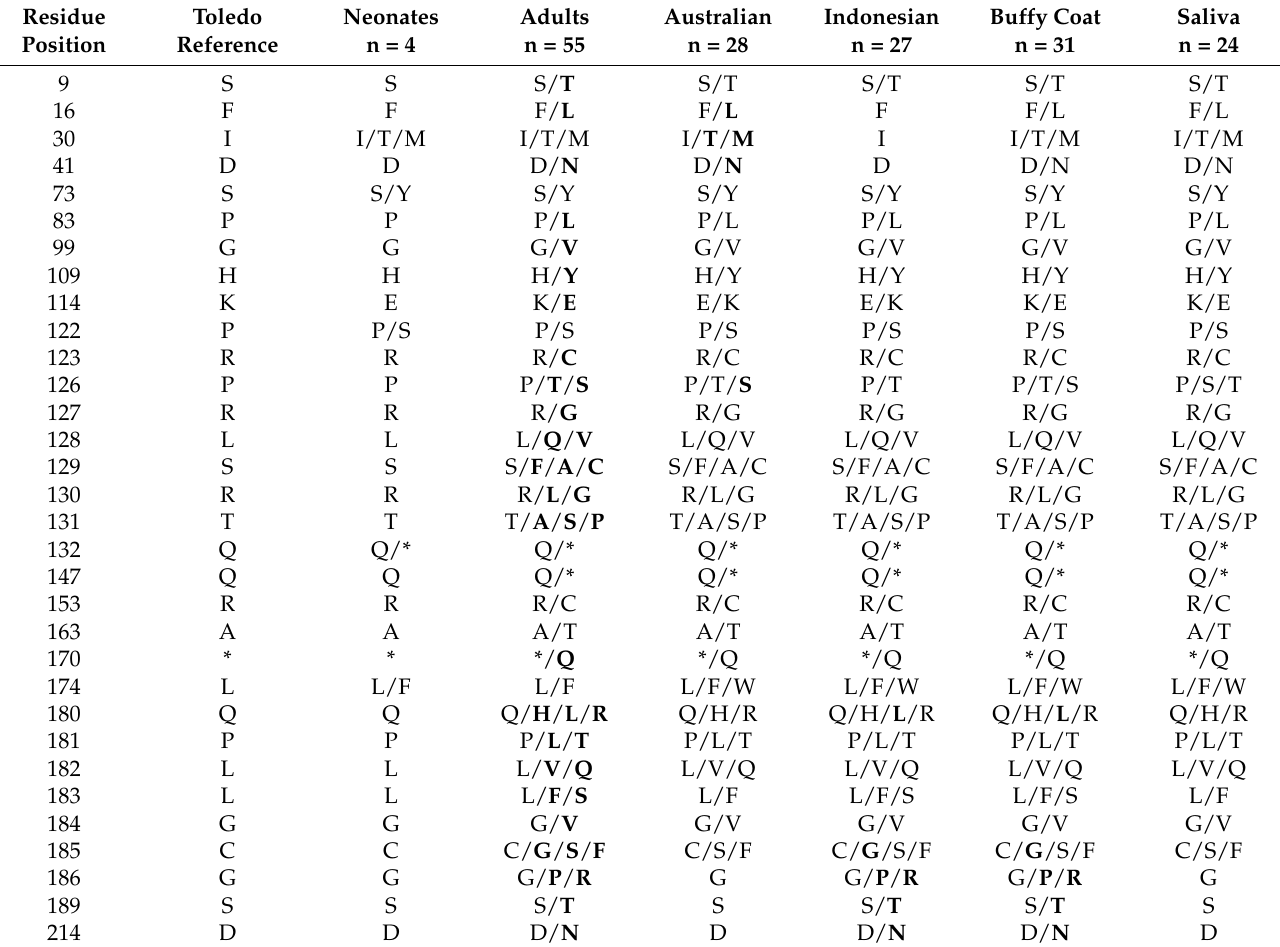
Table 1. UL111A protein variants distinct from Toledo were found in all